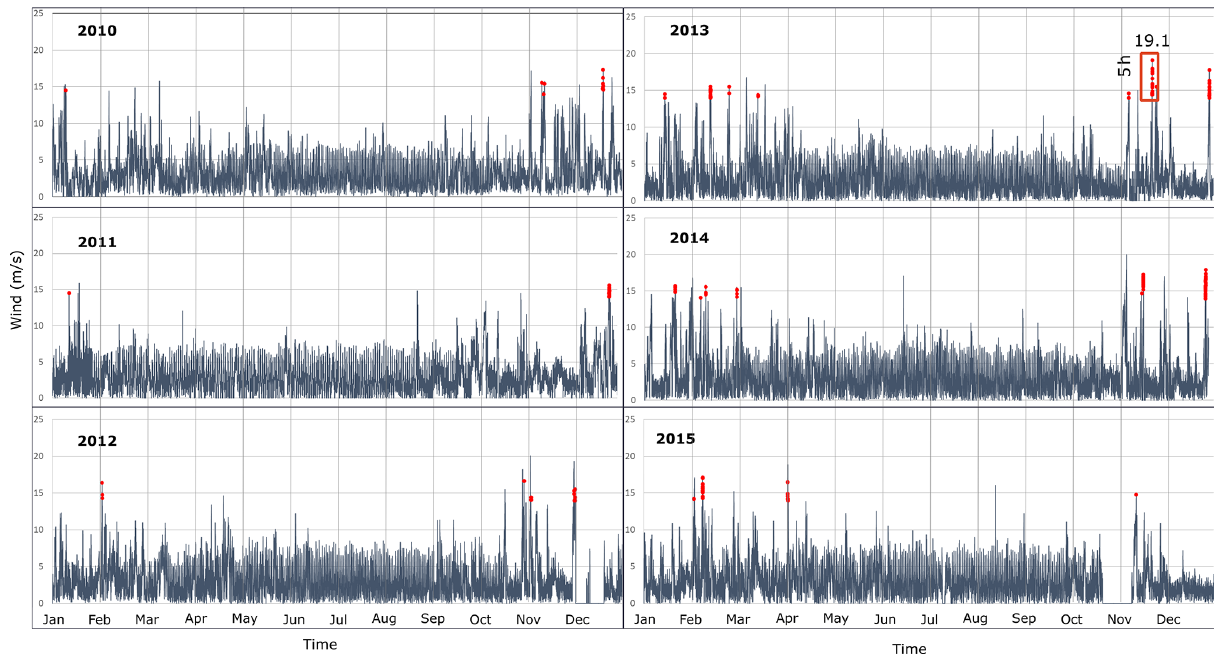
Figure 4. Graph of wind speed (m/s) between 2010 and 2015 measured by the P02 weather station; red points highlight storms from 202– 242 ◦ with a velocity higher than